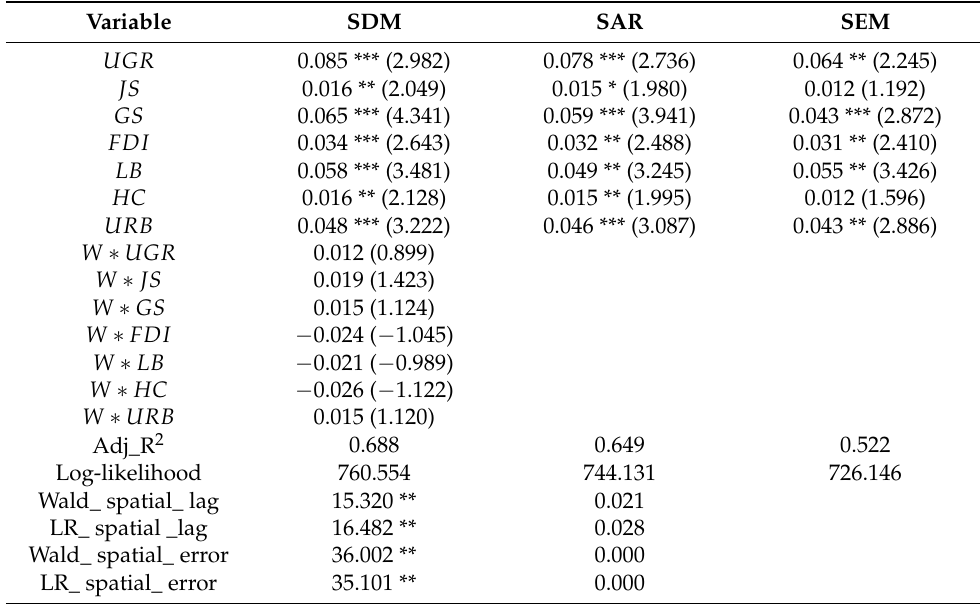
Table 6. Estimated results of spatial econometric